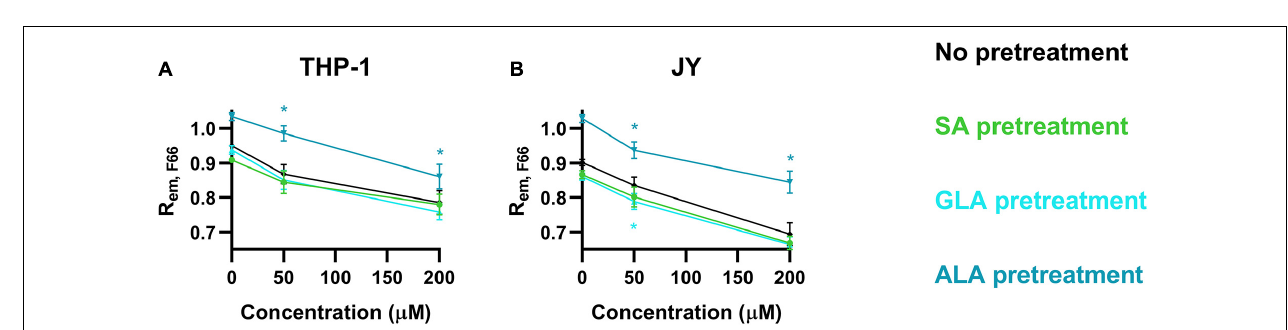
FIGURE 5 | Correlations between F66 emission ratio and di-8-ANEPPS excitation ratio, TMA-DPH fluorescence anisotropy and PY3174 generalized polarization. THP-1 (A–C) or JY (D–F) cells were treated with 200 µ M 7DHC (yellow), cholesterol (orange) or 6KC (red) for 1 h, or 50 µ M ALA (blue), GLA (cyan) or SA (green) for 48 h, which was followed by labeling and determination of F66 emission ratio, di-8-ANEPPS excitation ratio, TMA-DPH fluorescence anisotropy and PY3174 generalized polarization, as described previously in detail. Average values ( ± SD) of the F66 excitation ratio were plotted as function of di-8-ANEPPS excitation ratios (A,D) , TMA-DPH fluorescence anisotropy (B,E) or PY3174 generalized polarization values (C,F) . R 2 and p values determined with linear regression analysis are shown in the panels.